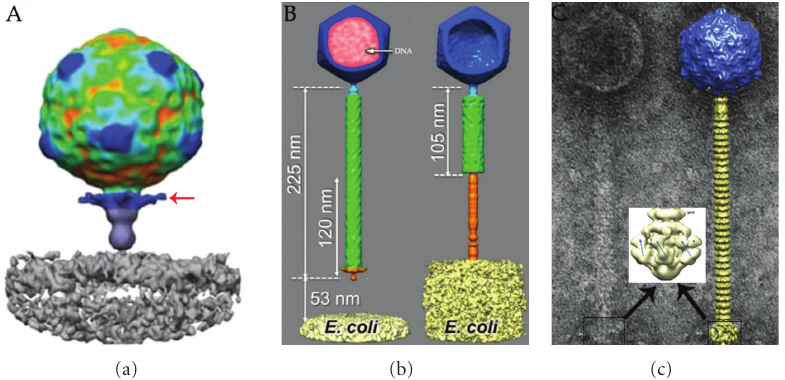
Figure 3: Observation of bacteriophage-host interaction with cryoelectron microscopy. (a) Cryo-electron tomography of podovirus P-SSP7 infecting Prochlorococcus. An infecting phage subtomograms with the portal vertex oriented to the cell surface. The phage tail fibers are extended horizontally (red arrow marked) [24]. (b) Conformational changes of phage P1 during tail contraction and DNA injection. The E.coli marked is only part of the cell, DNA marked pink stays in the capsid, and the tail is not contracted (left). Structure of the contracted phages has no DNA (right) [26]. (c) Electron micrograph of the virulent lactococcal phage p2. Overall structure of phage p2 (right) showing the capsid (blue, top), the tail, formed of rings of the major tail protein hexamers (gold), the globular baseplate (gold, bottom) (insert). The baseplate is reconstructed by single particles analysis. The receptor-binding protein (RBP) positions are identified by blue arrows or a blue dot. The RBP head is pointing upwards